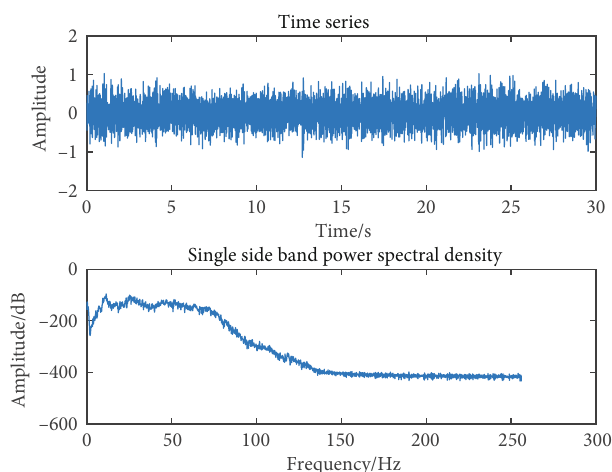
Figure 14: Time series and PSD of the horizontal tail in